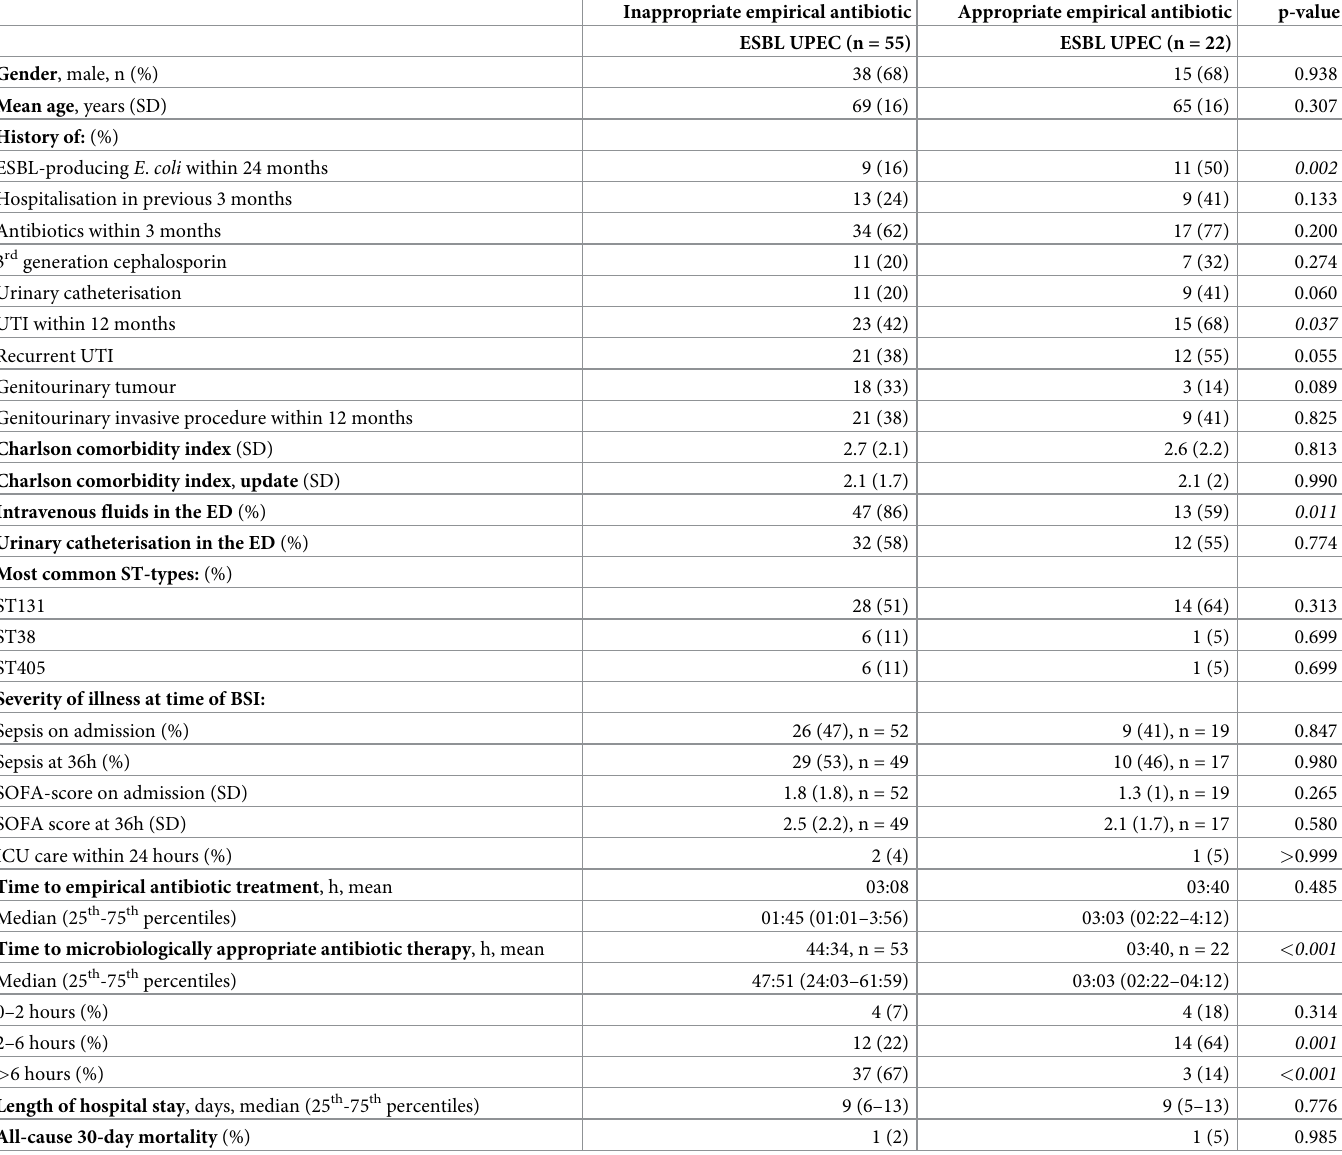
Table 3. Subgroup analysis of ESBL UPEC (n = 77); inappropriate vs. appropriate empirical antibiotics a .